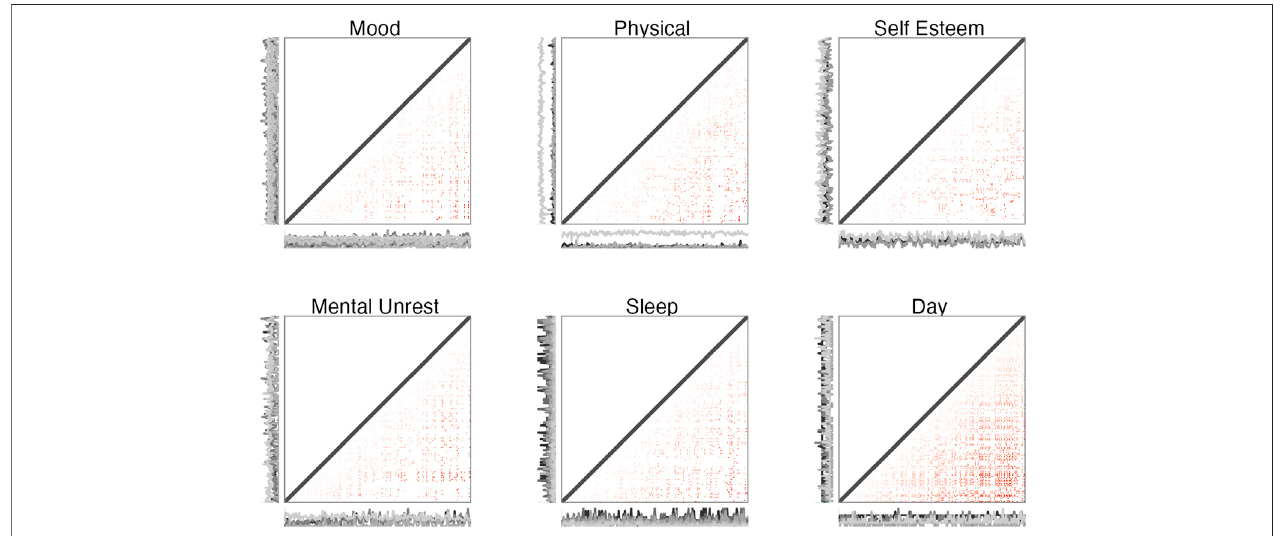
FIGURE7 | Weighted, directed matricesfor constructing cumulative Recurrence Networks ofselected variables of themultivariate dataset.The weights represent recurrence times. The direction is implemented by only considering the recurrent points in the lower triangle, and calculating measures based on the out-degree.